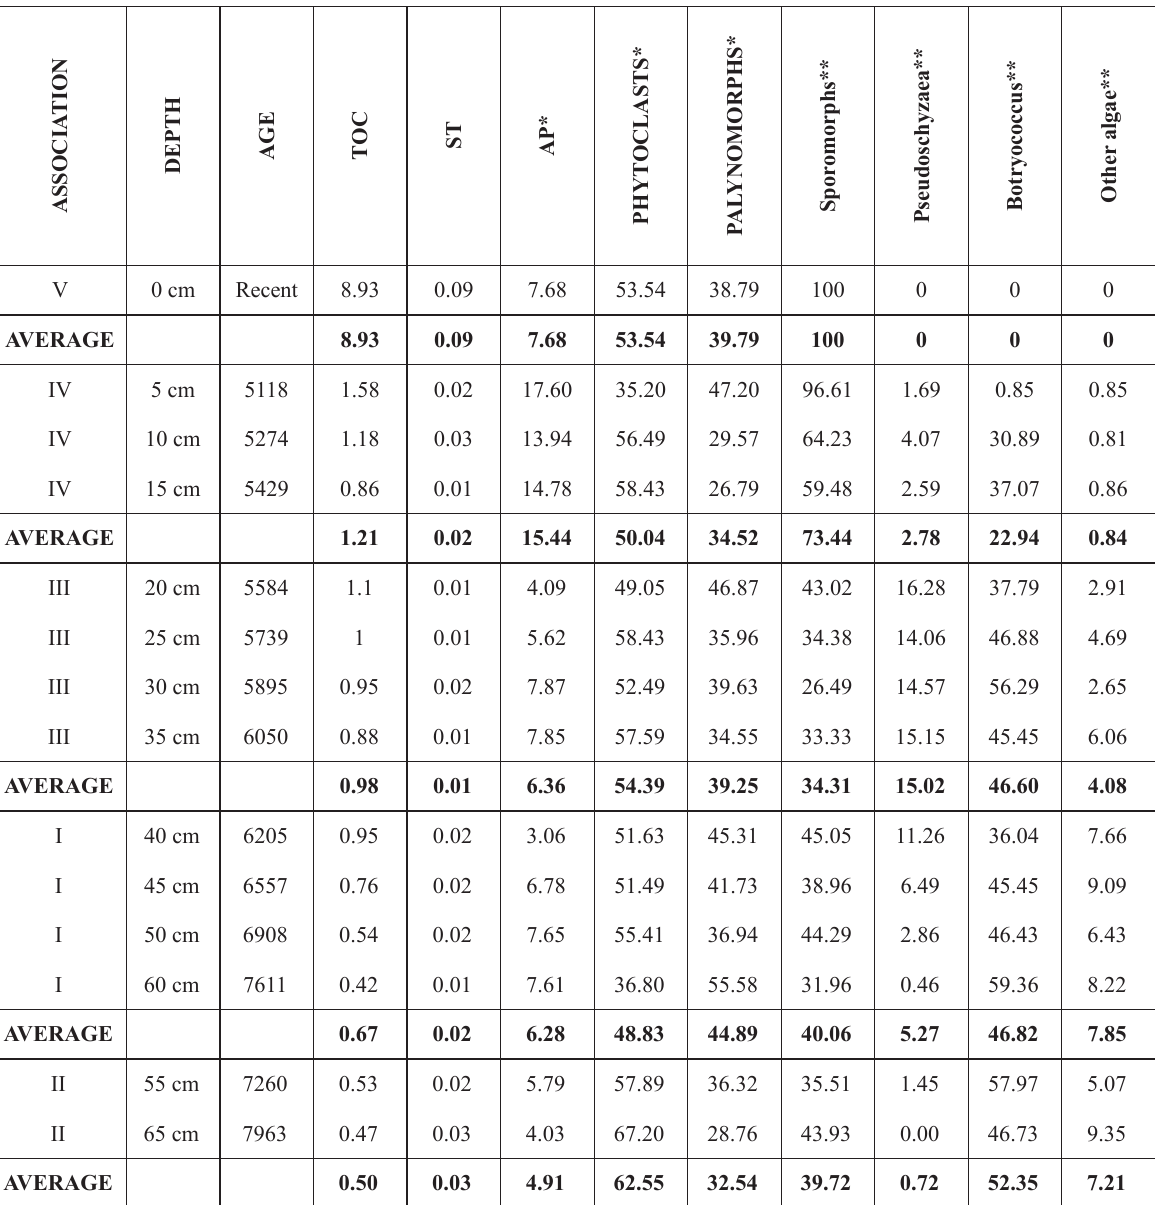
Table showing the percentages of the TOC and ST and the percentages of the major groups and subgroups of the POM and of the averages of the sample groups. (*) Percentage value of the three main groups of POM related to total organic matter. (**) Percentage value of palynomorphs related to the total palynomorph group. Abbreviations are in accordance with Fig.